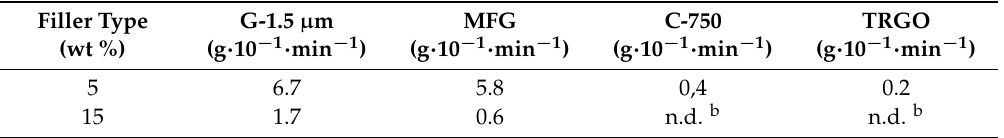
Table 2. Melt flow index (MFI) of carbon/acrylonitrile–butadiene–styrene copolymer (ABS) nanocomposites a . Filler